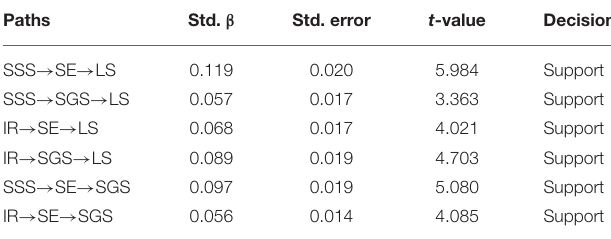
TABLE 5 | Indirect effect of the structural model.